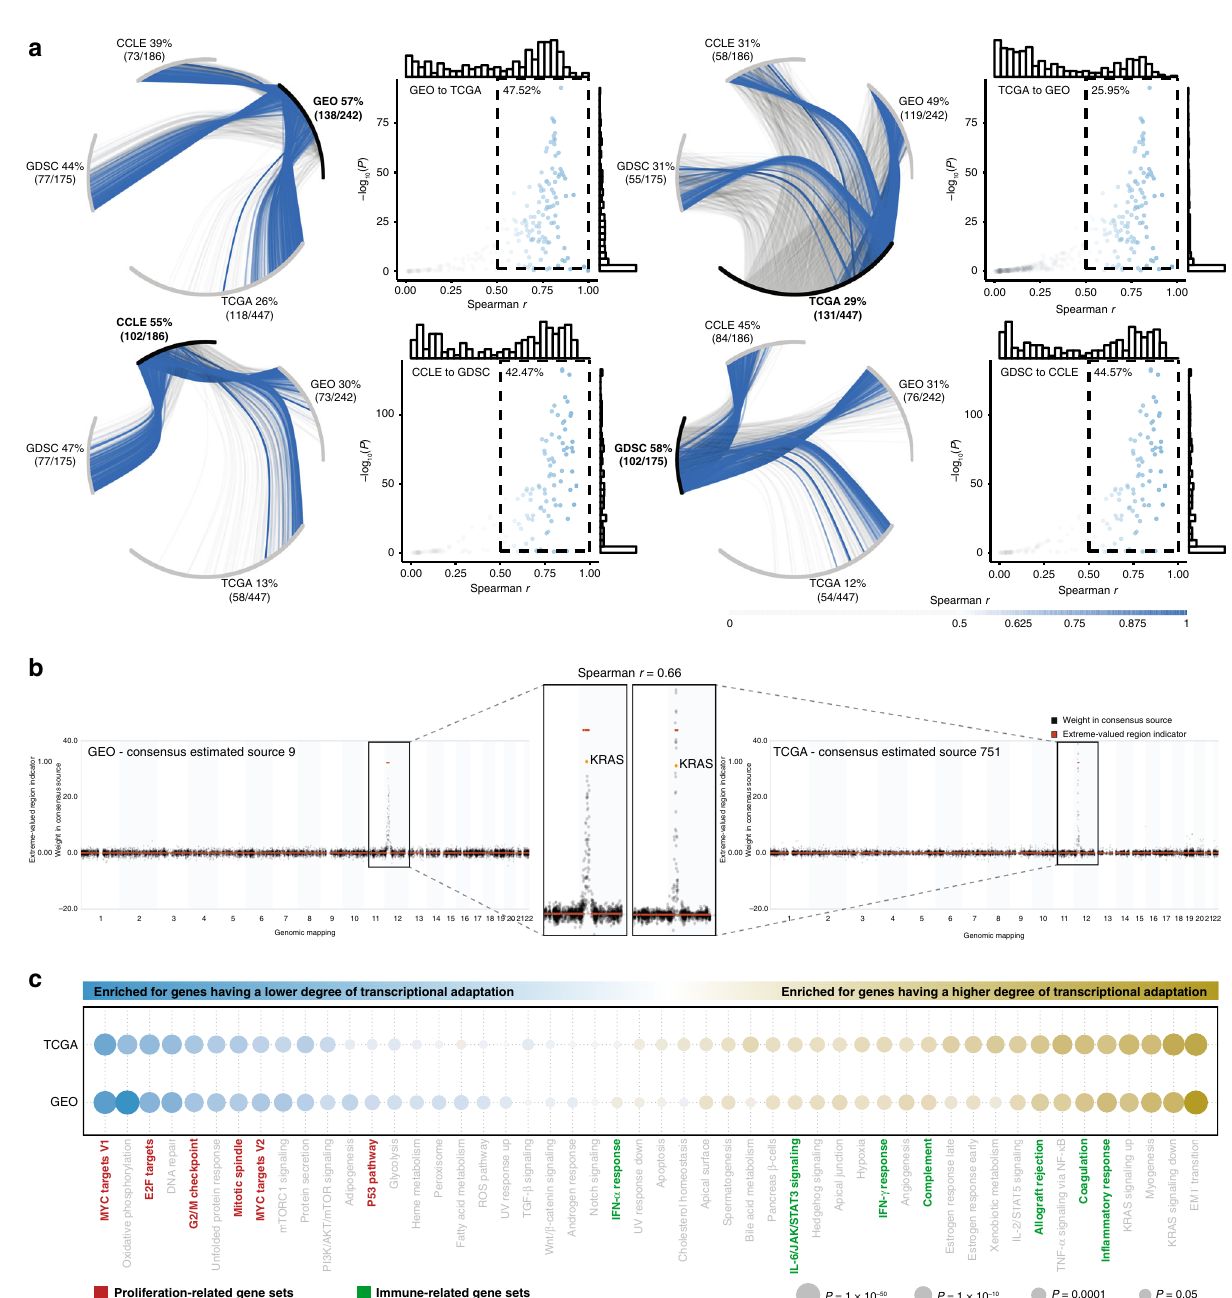
Fig. 3 Degree of transcriptional adaptation to CNAs. a Citrus plots showing the Spearman correlations between CNA-CESs in the reference dataset, depicted in bold, with CNA-CESs in the other three datasets. Blue lines indicate r > 0.5. Correlations are calculated based on the weights of genes in marked genomic regions of the CNA-CESs under investigation. Each scatterplot with marginal histograms shows the correlations versus their − log 10 transformed P values. The inset shows correlations > 0.5 having a P value < 0.05. b Example of a CNA-CESs in the GEO dataset that is highly correlated with a CNA-CES in the TCGA dataset with KRAS having a low degree of transcriptional adaptation to CNAs. Spearman correlation coef fi cient was derived using the genes mapping to the extreme-valued region from either of the CNA-CESs ( n = 38). c Enrichment results using two-sided Welch ’ s t -test for the MSigDB Hallmark collection. A yellow bubble indicates enrichment for genes with a high degree of transcriptional adaptation to CNAs, and a blue bubble indicates a low degree. The size of the bubble corresponds to the signi fi cance level. Only CNA-CESs having at least 50 genes in their marked region were included. EMT: epithelial-mesenchymal transition; ROS: reactive oxygen marked genomic region in only one CNA-CES (Supplementary protein complex subunits in response to the occurrence of CNAs Data 12). The degree of transcriptional adaptation of these genes (Supplementary Fig. 10 and Supplementary Data 11). ( n = 7641) highly correlated between the GEO and TCGA dataset (Fig. 4a, r = 0.84). Of these 7641 genes, 786 (10.2%) had low adaptation (metric < 0.25), 3898 (51.0%) moderate adaptation (metric 0.25 – 0.75), and 2957 genes (38.7%) high adaptation In both the GEO and TCGA dataset, most genes mapped to a